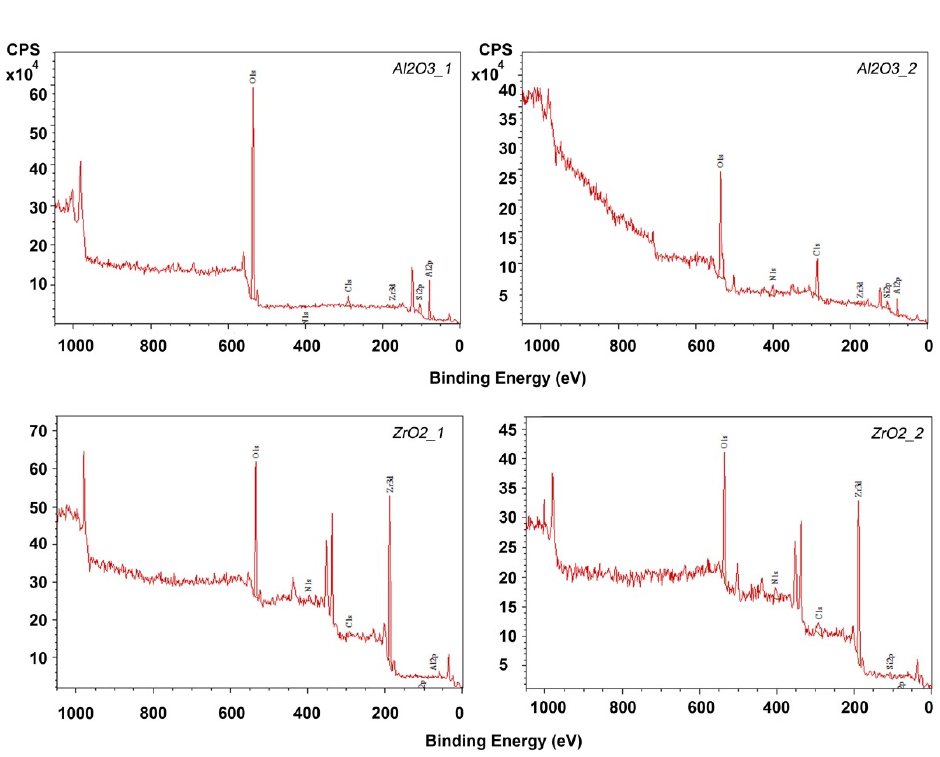
Figure 8. XPS survey spectra for powders etched in Piranha Solution and chemically